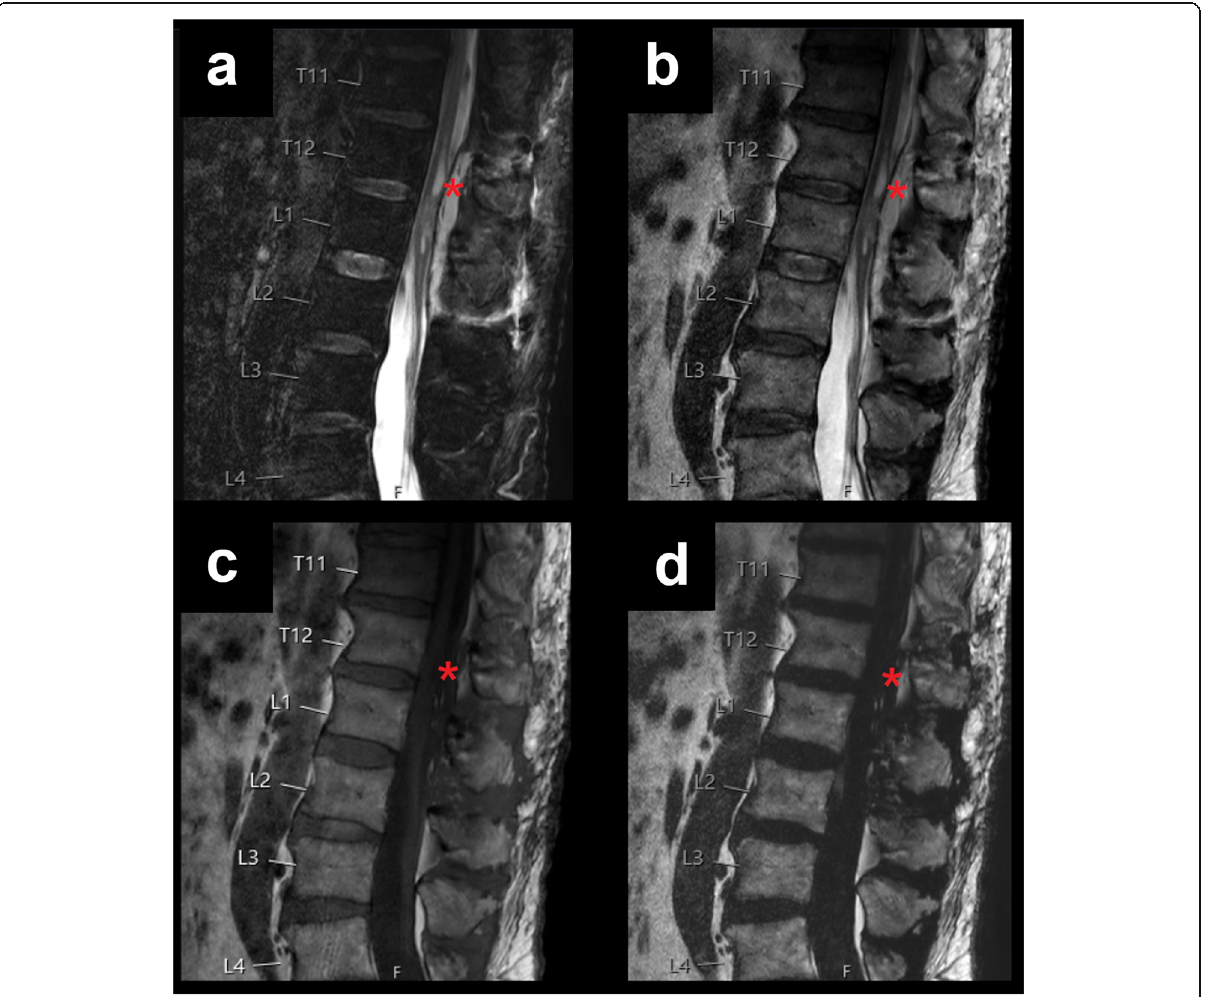
Fig. 4 Postoperative thoracolumbar haematoma. This figure shows the lower thoracic and lumbar spine of a 69-year-old male patient using water-only images ( a ), in-phase images ( b ), and fat-only images ( d ) of the sagittal T2-weighted DIXON sequence, together with a sagittal T1- weighted sequence ( c ). The patient had undergone decompressive lumbar surgery and presented with a postoperative epidural haematoma between T12 and L2 (red